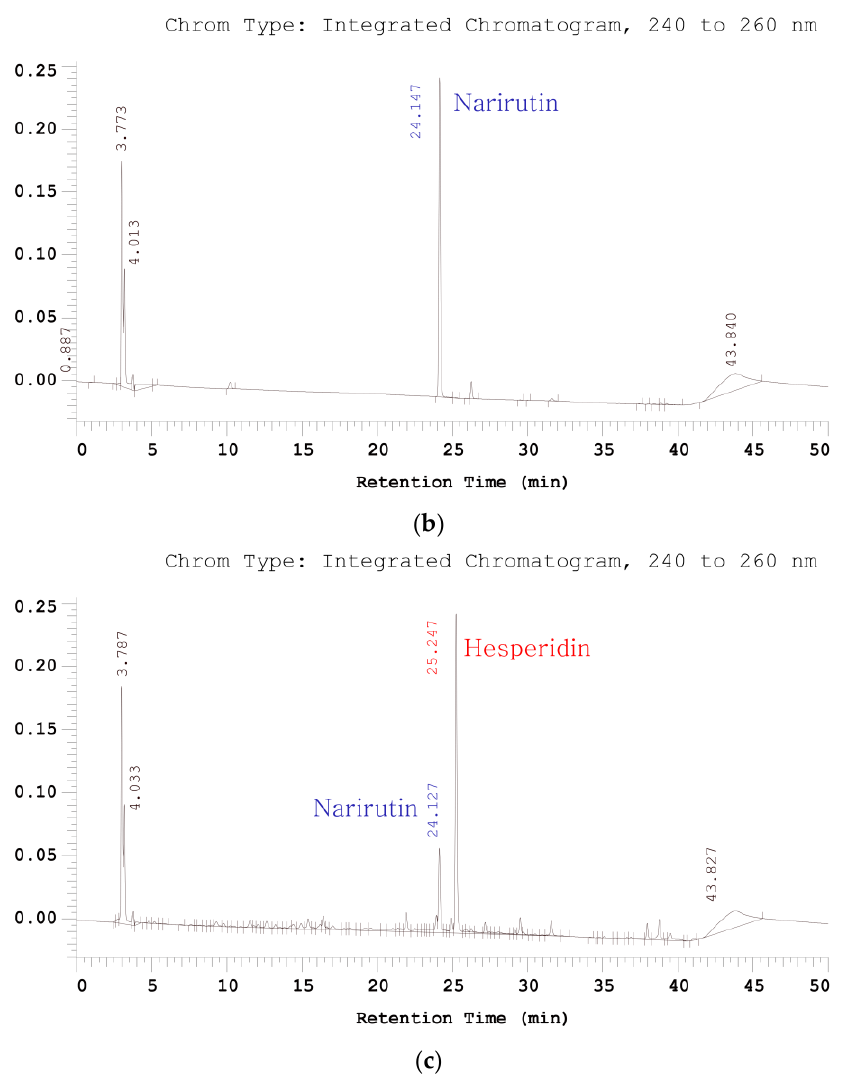
Figure A1. HPLC chromatogram for hesperidin standard ( a ); narirutin standard ( b ); mandarin peel extracts ( c ).